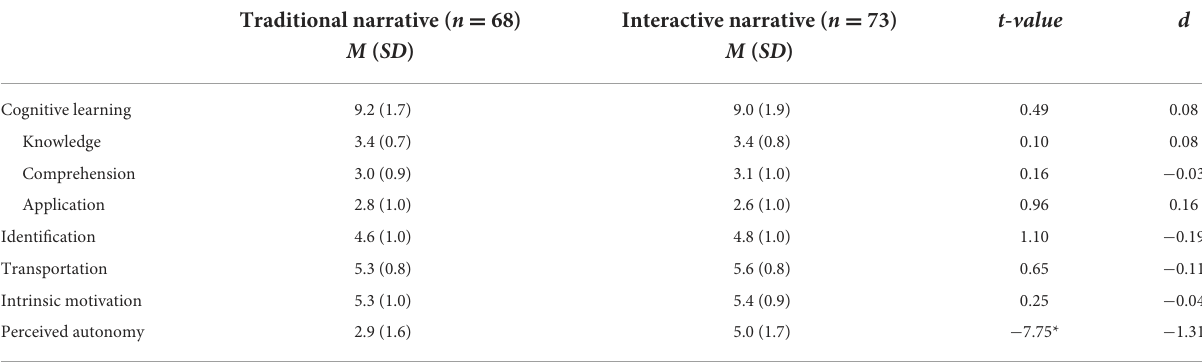
TABLE 2 Overview of descriptives, t -values and effect sizes per condition for experiment 1. Traditional narrative ( n = 68)